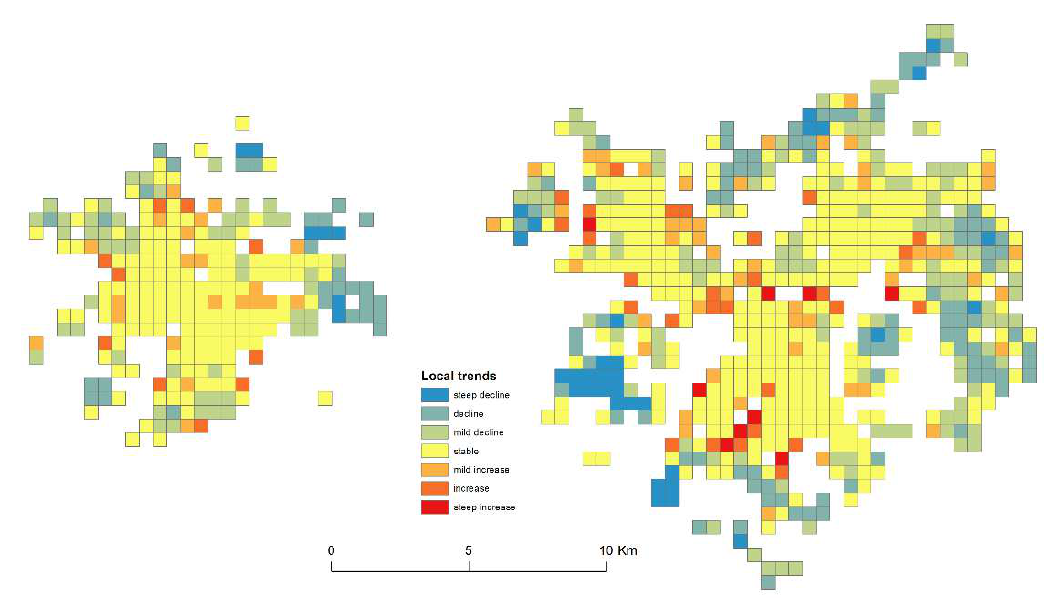
Figure 6. Local development of WAI from 400 m to 2414 m for Hradec Kralove and Ostrava. Different local trends of WAI can be seen in the maps. The main settlements of the cities are stable and do not change classification of WAI with extension of searching radii.